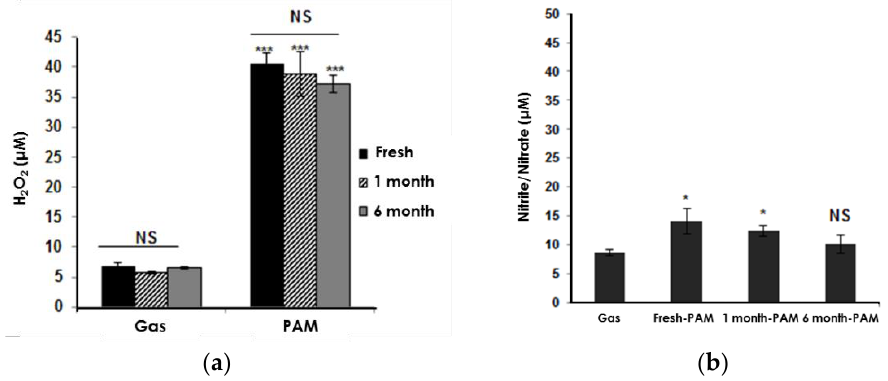
Figure 7. Reactive species in stock PAM were stably maintained. H 2 O 2 ( a ) and nitrite/nitrate ( b ) in fresh and stock PAM were quantified. PAM was stored in a freezer ( − 20 ◦ C) for the indicated periods (1 or 6 months) and then thawed to assess H 2 O 2 and nitrite/nitrate levels. DMEM served as a control. NS, not significant; * p ≤ 0.05, ** p ≤ 0.01, *** p ≤ 0.001.